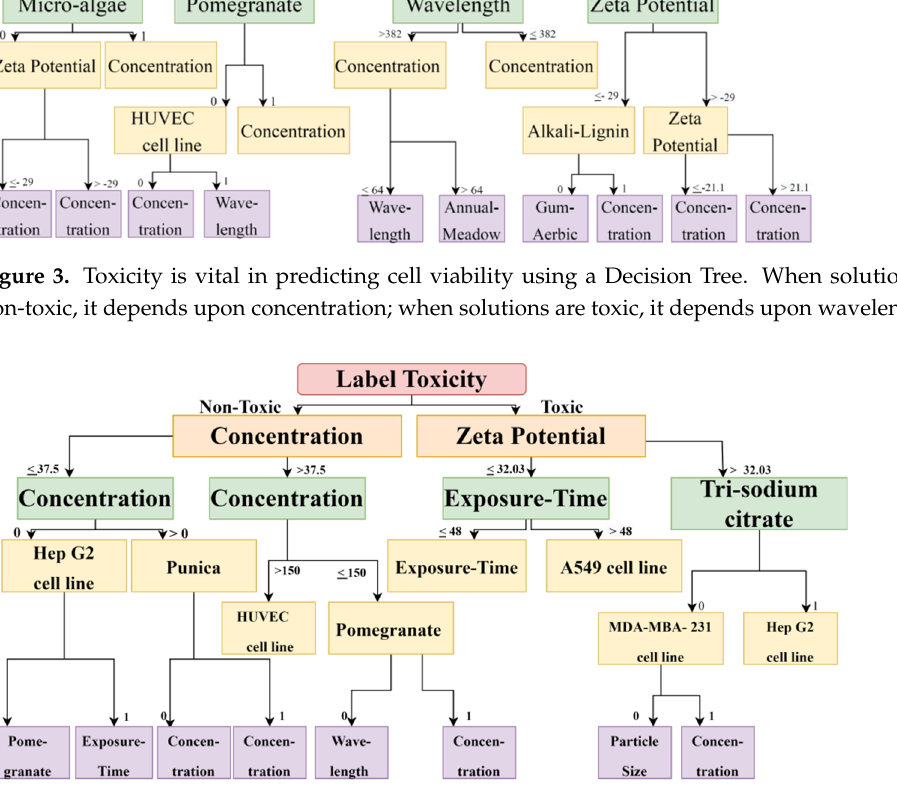
Figure 4. The decision Tree diagram confirms that, for calculating cytotoxicity and cell viability for carcinoma cell lines, zeta potential, exposure time, reducing agent, and concentration are important factors.